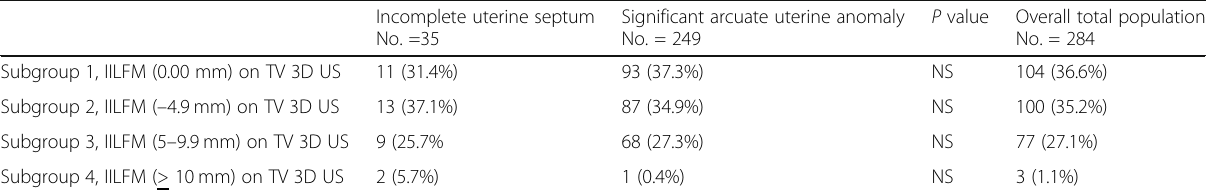
Table 2 Percentage of patients with IUS and AUA and moderate internal indentation (10 – 14 mm) on hysteroscopy, in 4 subgroups based on the internal indentation length on TV 3D US with or without SIH Incomplete uterine septum Significant arcuate uterine anomaly No. =35 No. =